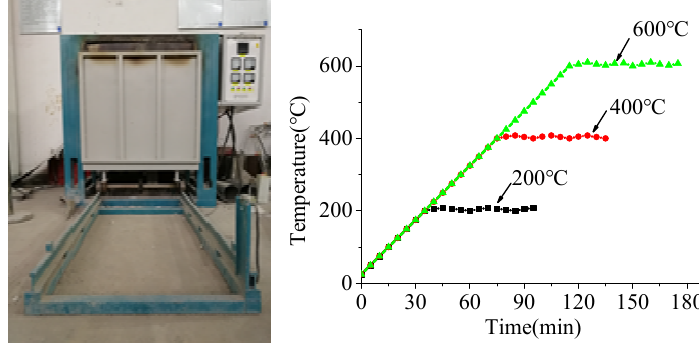
Figure 1. The electrical furnace and temperature recorded by the furnace.